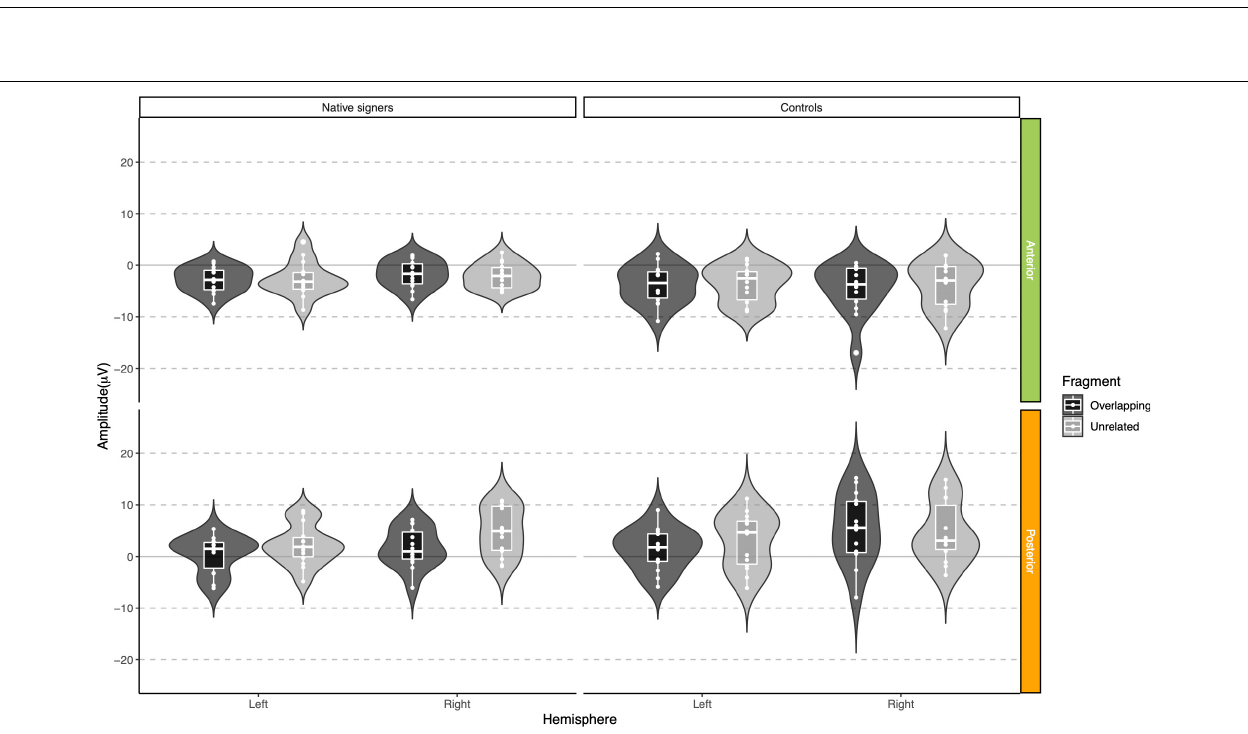
FIGURE 9 | Violin-boxplots depicting mean amplitude for the N400/negativity in the 200–400 ms time window for Native signers (left) and Controls (right) for the Unrelated (light gray) and Overlapping (dark gray) fragments across regions of interest.